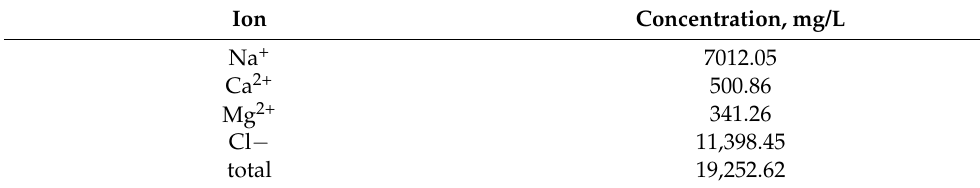
Table 1. Ionic element composition of the synthesized brine used.